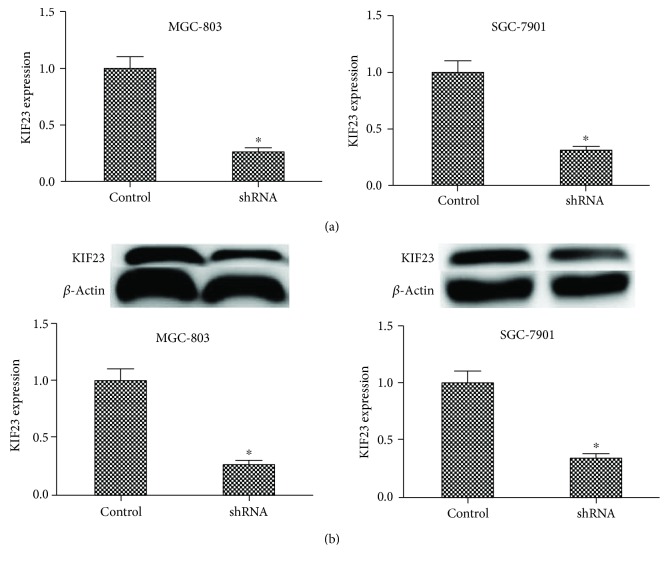
KIF23 was adequately depleted in two types of human gastric cancer cells. (a) Results of the qRT-PCR assay showed that the expression level of KIF23 was sufficiently knocked down in the MGC-803 and SGC-7901 gastric cancer cells, respectively. (b) Results of the western blot assay revealed that the KIF23 gene was efficiently silenced in MGC-803 and SGC-7901 cells. Results are presented as mean ± SD (∗P < 0.05).